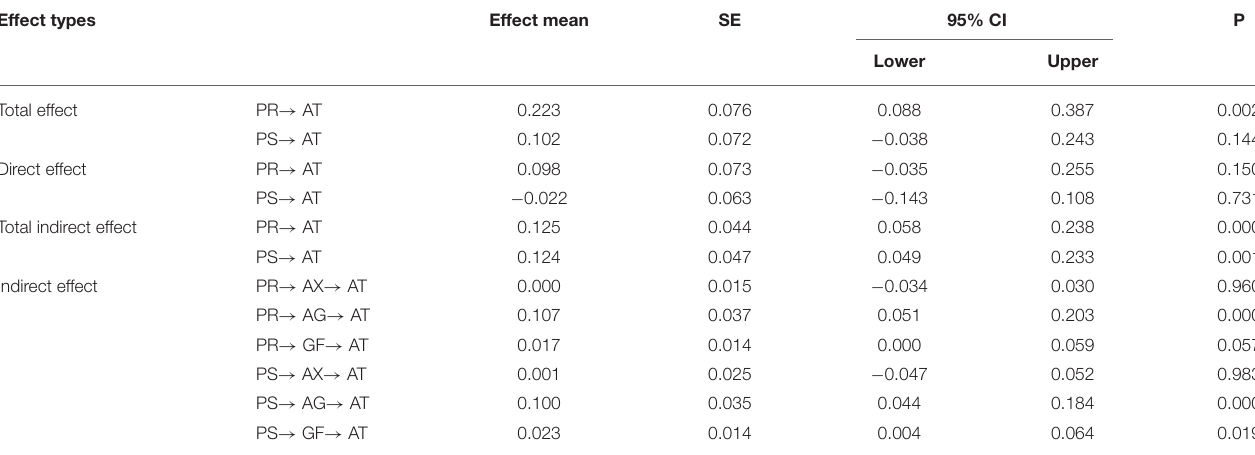
TABLE 4 | Direct, indirect, and total effect (Bootstrap =